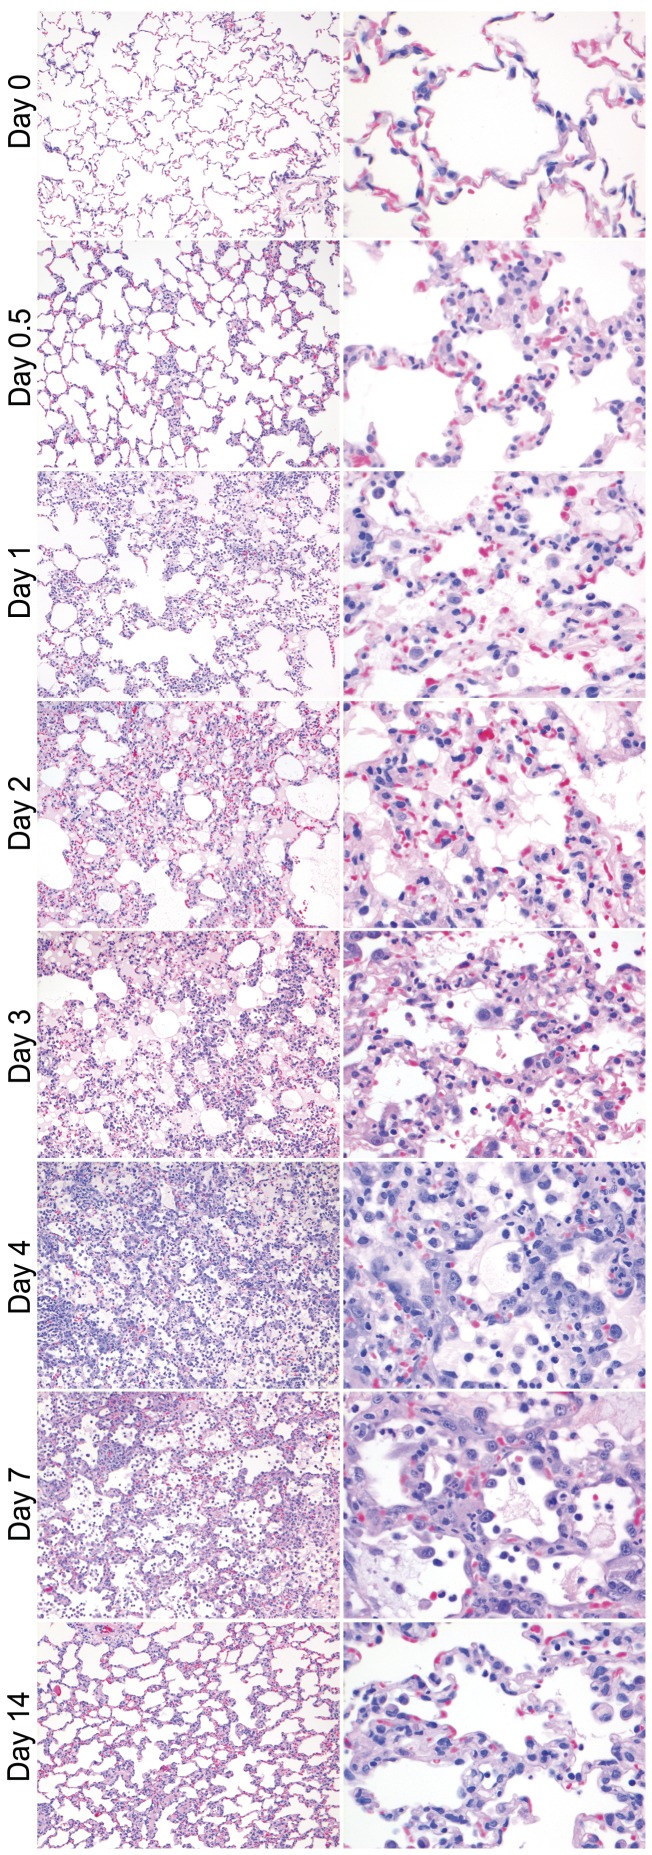
Histopathologic changes in the alveoli during time in ferrets inoculated with pH1N1.On 0.5 dpi there was mild DAD that was characterized by neutrophils in the alveolar walls. On 1 dpi the alveolar walls were thickened with mild necrosis of the lining epithelium and increased number of neutrophils, in the lumina there were more mononuclear cells, little amount of edema fluid mixed with fibrin, hemorrhage and little cellular debris. On 2 dpi there was increased presence of necrosis, edema, hemorrhage and hyperplasia. On 3 dpi there were both new lesions with acute necrosis and old lesions with type II hyperplasia present, with increased amounts of edema and hemorrhage. On 4 dpi the type II hyperplasia and hypertrophy was more pronounced with increased amount of edema and high numbers of mononuclear cells. On 7 dpi there was severe epithelial hyperplasia and hypertrophy as well as intraluminal edema and hemorrhage. On 14 dpi the walls were mildly thickened. HE, 100× (first column), 400× (second column).